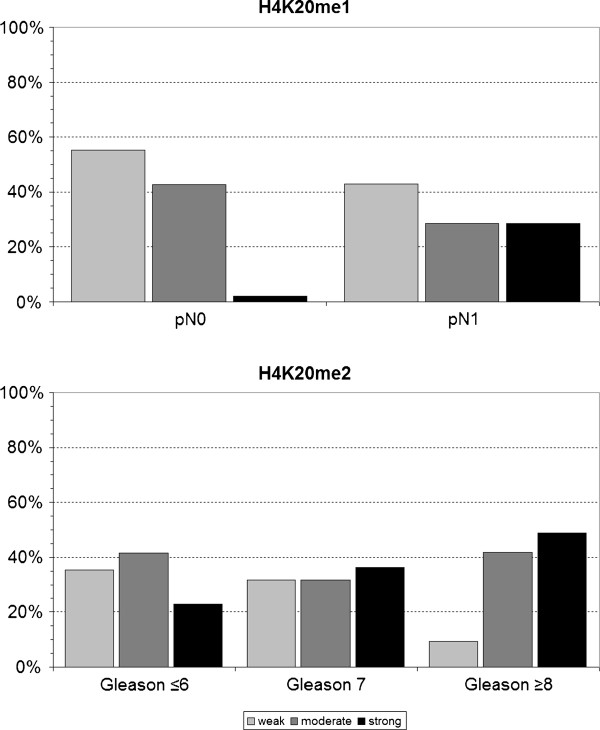
Correlation of global H4K20 methylation levels with adverse clinical-pathological parameters: H4K20me1 was positively correlated with lymph node involvement and H4K20me2 was correlated with Gleason Score.